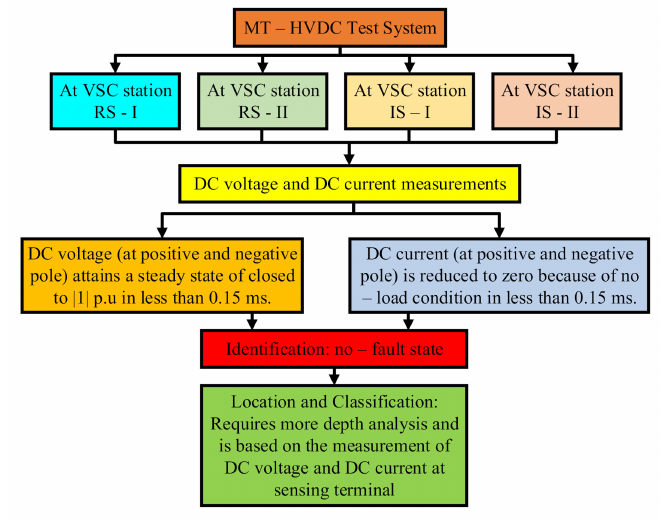
Figure 14. No-fault identification scheme in the MT-HVDC